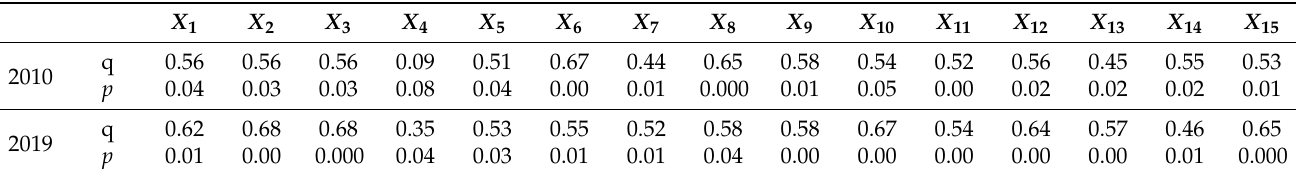
Table 3. Factor detection analysis results of Geodetector in the